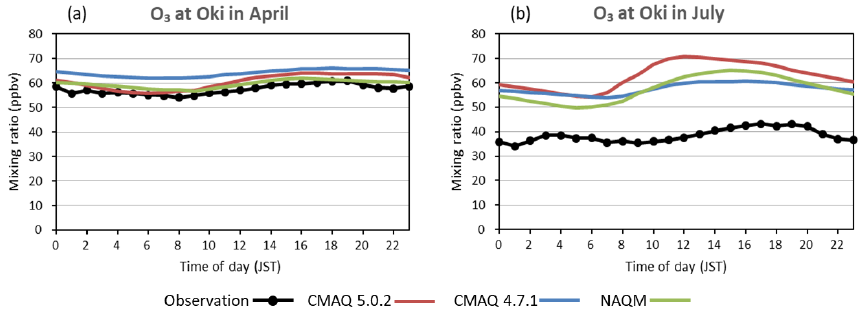
Figure 4. Monthly averaged diurnal variation in O 3 at Oki (a) in April and (b) in July.